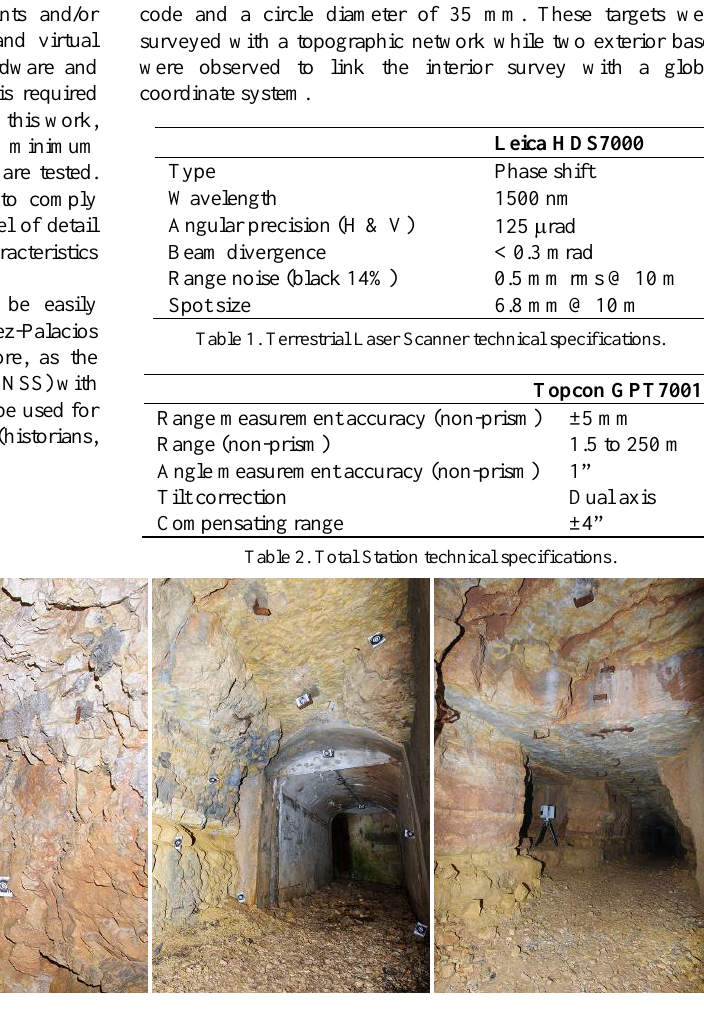
Figure 2. The tunnel - connecting the Viaz and Oberwiesen outposts of the Lusern fortification - with the topographic targets (left and middle) and a TLS station